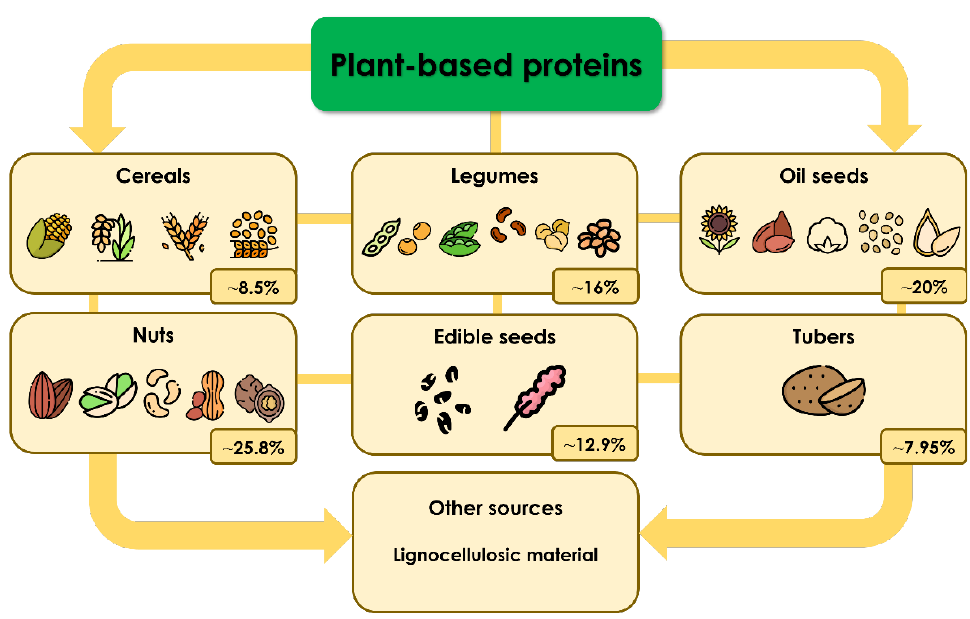
Figure 1. Classification of plant-based proteins and their average protein content. Protein data were obtained from [6 – 12].